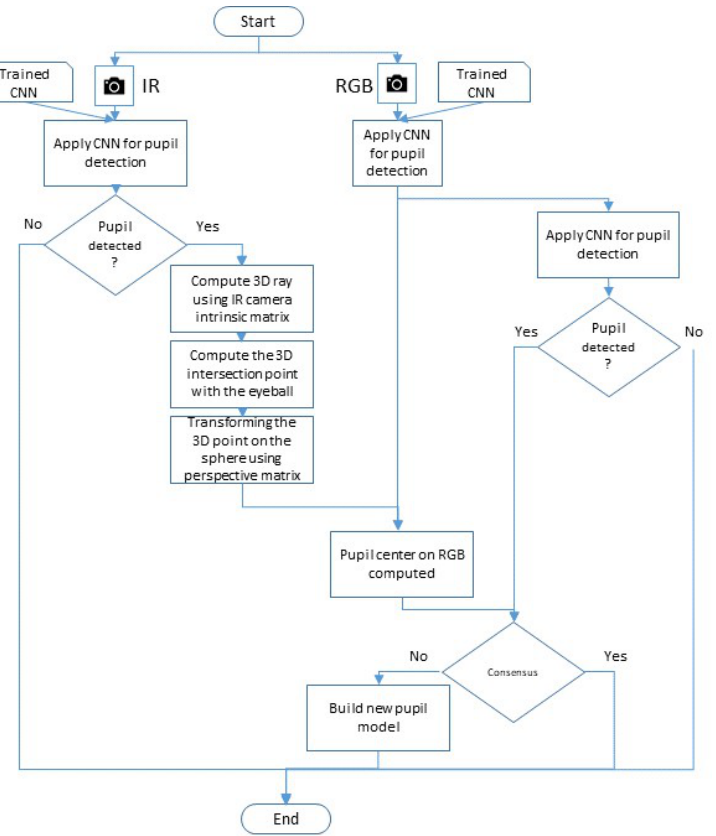
Figure 5. The flowchart for the point-to-point model transformation using the IR and RGB eye